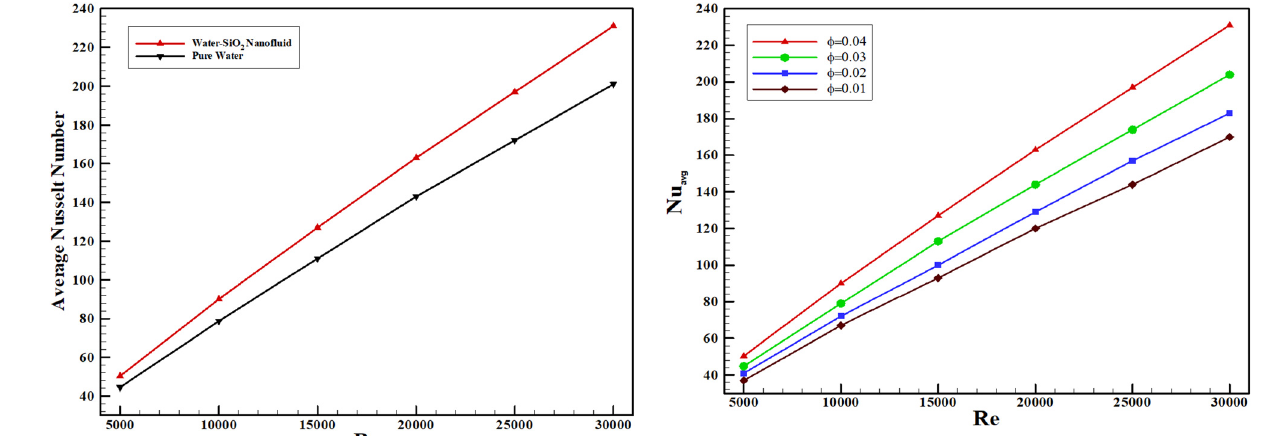
Figure 2: Reynolds number and Nusselt number variation using water/SiO 2 nano fl uid and pure water for STC.